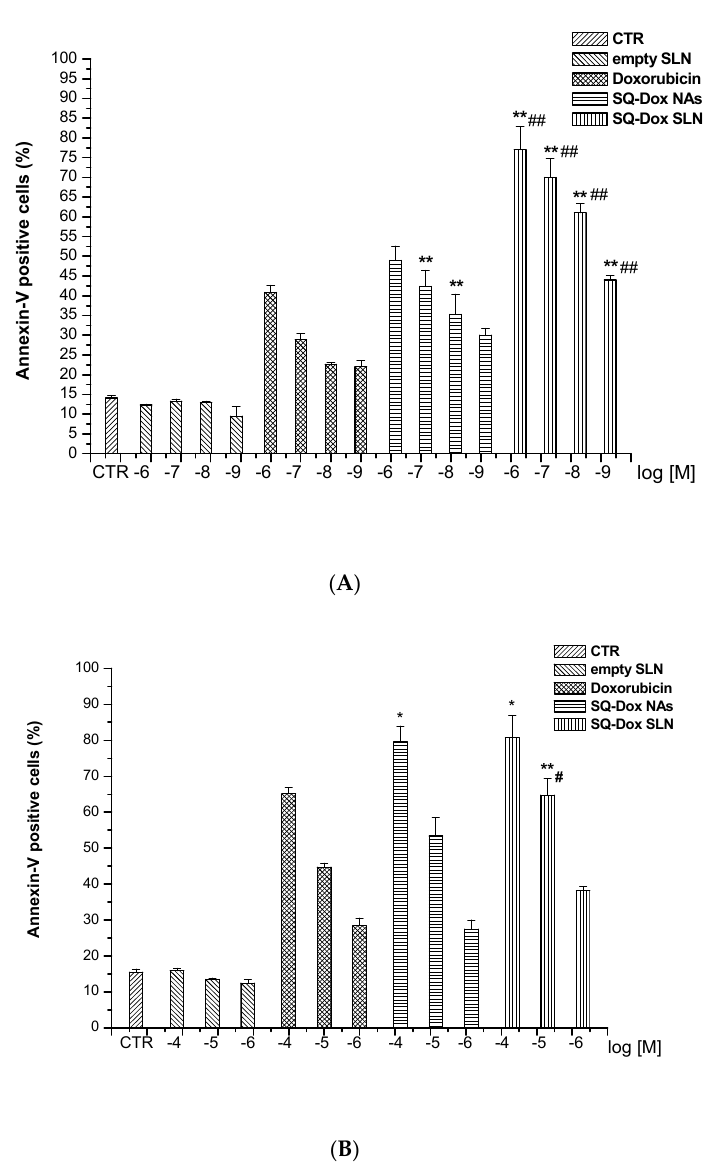
Figure 6. Levels of annexin-V-positive cells after Dox, SQ-Dox NAs, SQ-Dox SLN1 treatment. Annexin-V activity was evaluated in A2780 ( A ) and A2780 res ( B ) cell lines cultured for 72 h in either the presence or absence of Dox, SQ-Dox NAs, SQ-Dox SLN1 or empty SLNs. * p < 0.05 and ** p < 0.01, vs. Dox-treated cells at the same concentrations; # p < 0.05 and ## p < 0.01 vs. SQ-Dox-treated cells at the same concentrations, from three independent experiments.